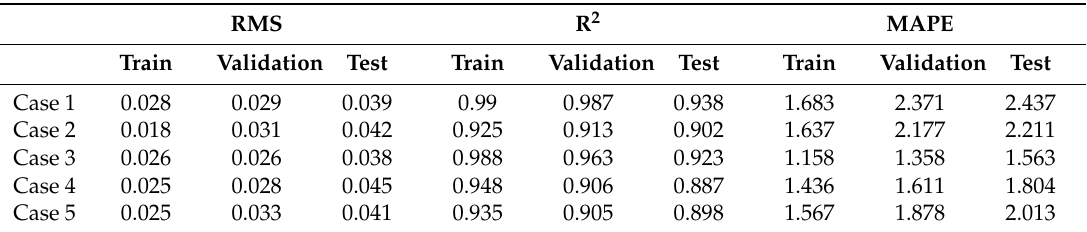
Table 2. Prediction indices for training networks. RMS—root mean square; R 2 —coefficient of determination; MAPE—mean absolute percentage error.